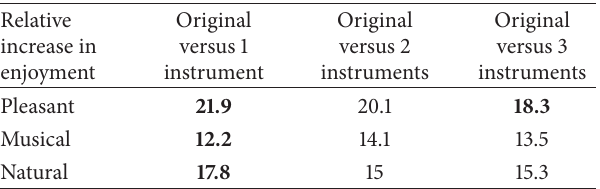
Table 3: Relative increase of enjoyment of the original music sample compared to modified versions containing 1–3 instruments among CI